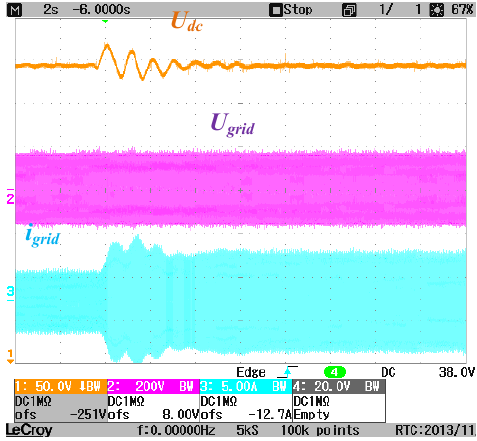
Fig. 15. Response for step change of speed. From top: speed reference (  ref ), estimated speed (  gen ), current in q-axis ( i q ), current in d-axis ( i d ).